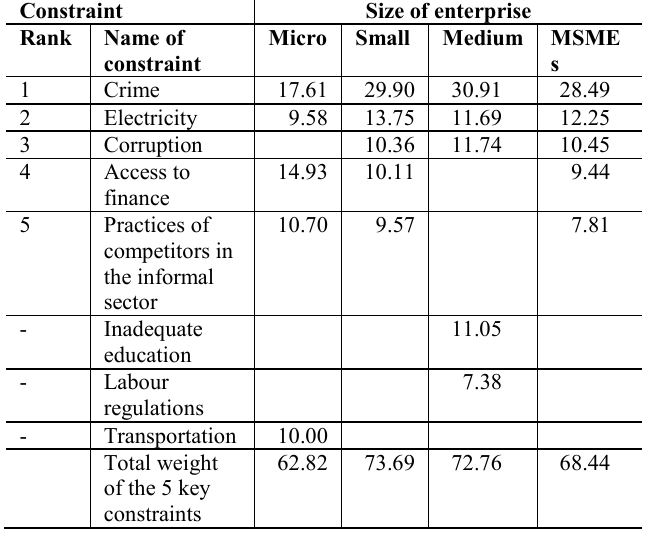
Table 1: Relative weights (%) of top 5 obstacles faced by MSMEs in South Africa